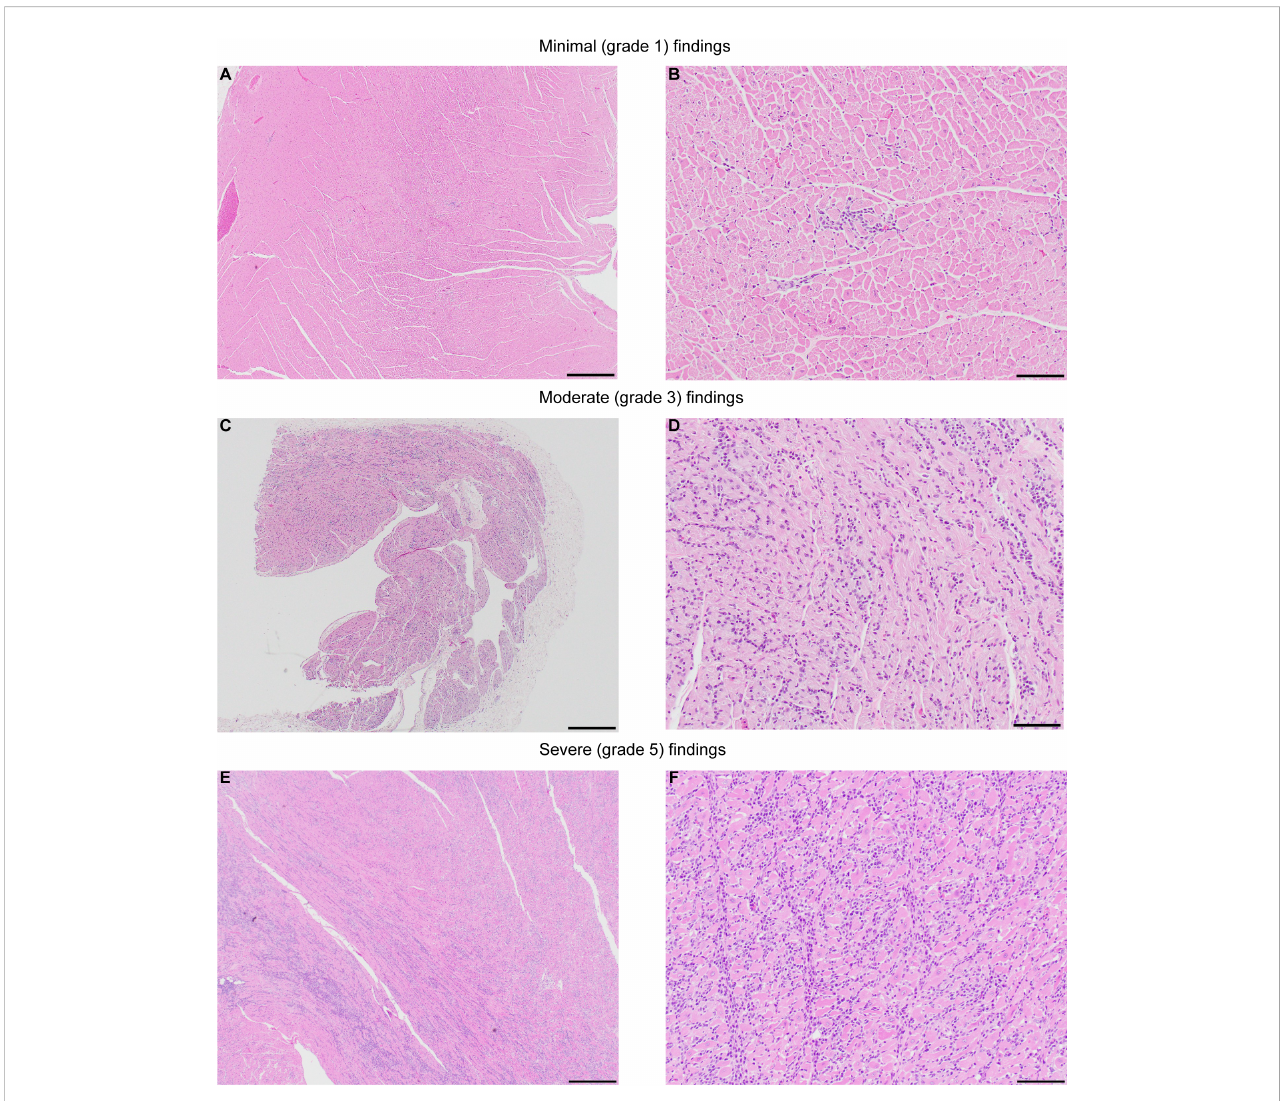
FIGURE 4 Representative images showing the severity range of microscopic fi ndings in heart. NHPs administered AAVhu68.vIGF2.hGAA at various routes of administration (ROA), including intravenous (IV 5x10 13 GC/kg) and combination IV (5x10 13 GC/kg) and ICM (3x10 13 GC). (A, B) animal RA3679, minimal (grade 1) myocardial mononuclear cell in fi ltrates, left ventricle. (C, D) Animal RA3607, moderate (grade 3) myocardial mononuclear cell in fi ltrates, right atrium. (E, F) Animal 180717, severe (grade 5) myocardial mononuclear cell in fi ltrates with associated fi brosis and moderate (grade 3)